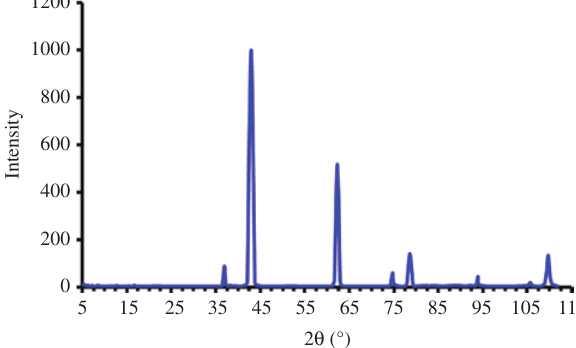
Figure 1: The X-ray diffraction (XRD) pattern of MgO